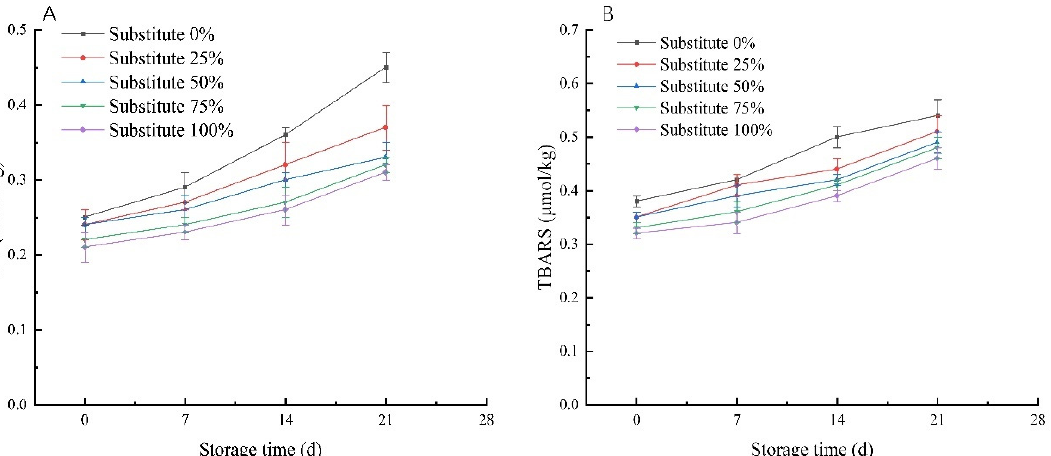
Figure 2. Effects of replacement of milk fat with SOBs on the PV value and TBARS value of yogurt: ( A ) PV value curves of yogurt with different substitution amounts; ( B ) TBARS value curves of yogurt with different substitution amounts.